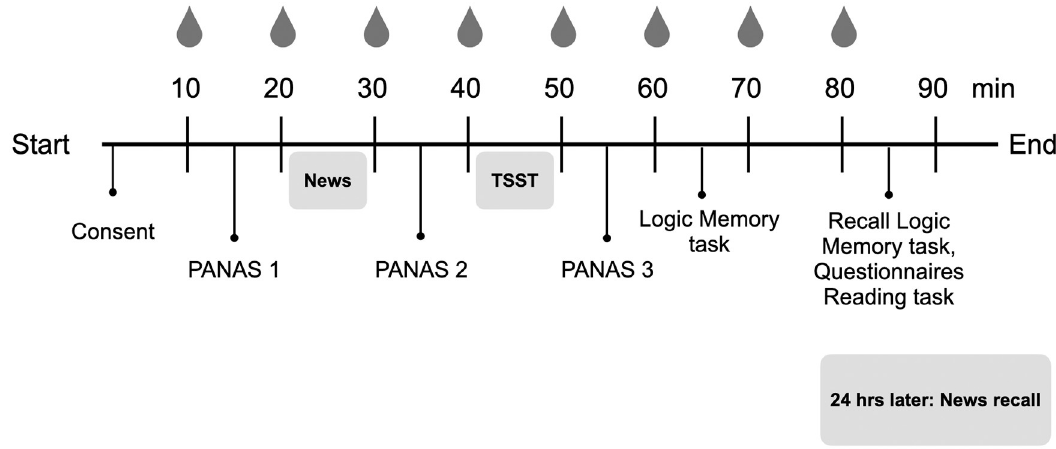
Fig 1. Schematic representation of the procedure. The figure shows the timeline for the laboratory